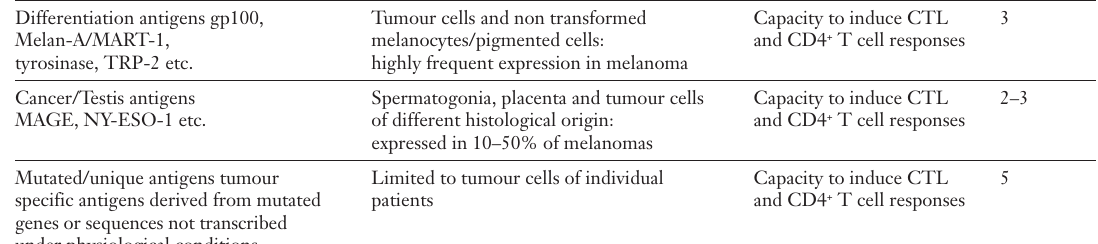
An overview of immunogens and treatment procedures most frequently used in immunotherapy of melanoma.